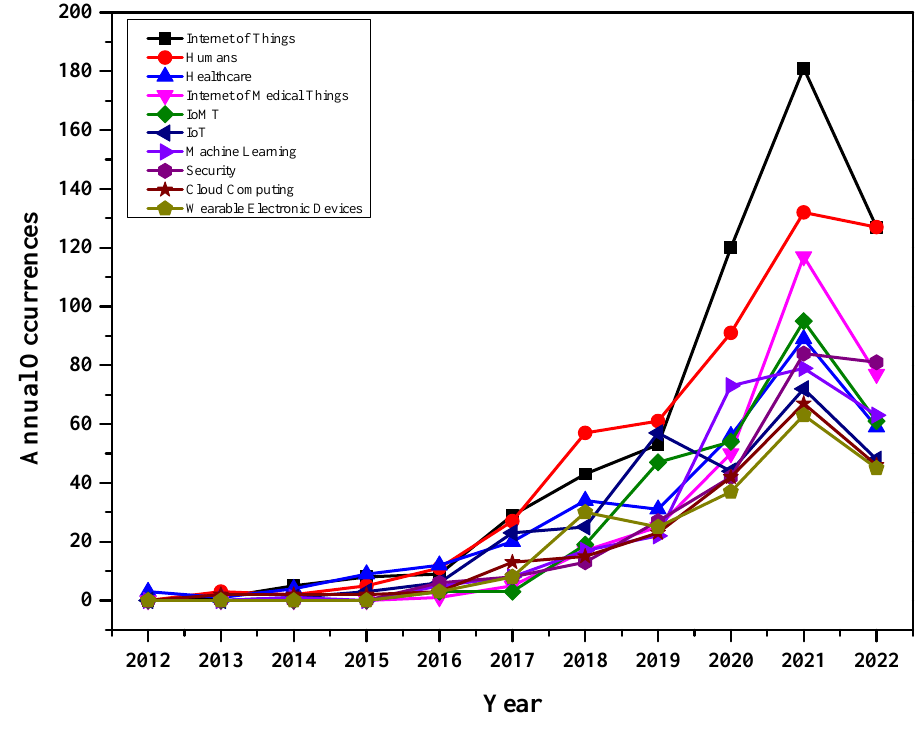
Figure 12. Annual Occurrences of author’s